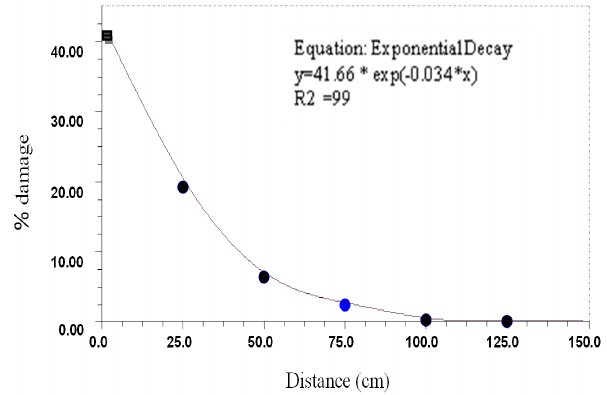
Fig. 3. Percent of damage in the single sugar beet in the neighbor of ground cherry